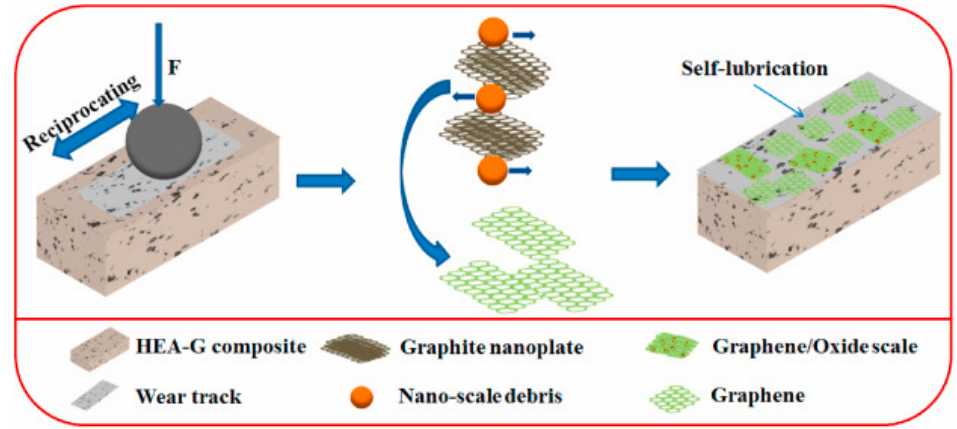
Figure 18. Self-lubrication mechanism of HEA-G composite. Reproduced with permission from [126]. Copyright Elsevier, 2021.